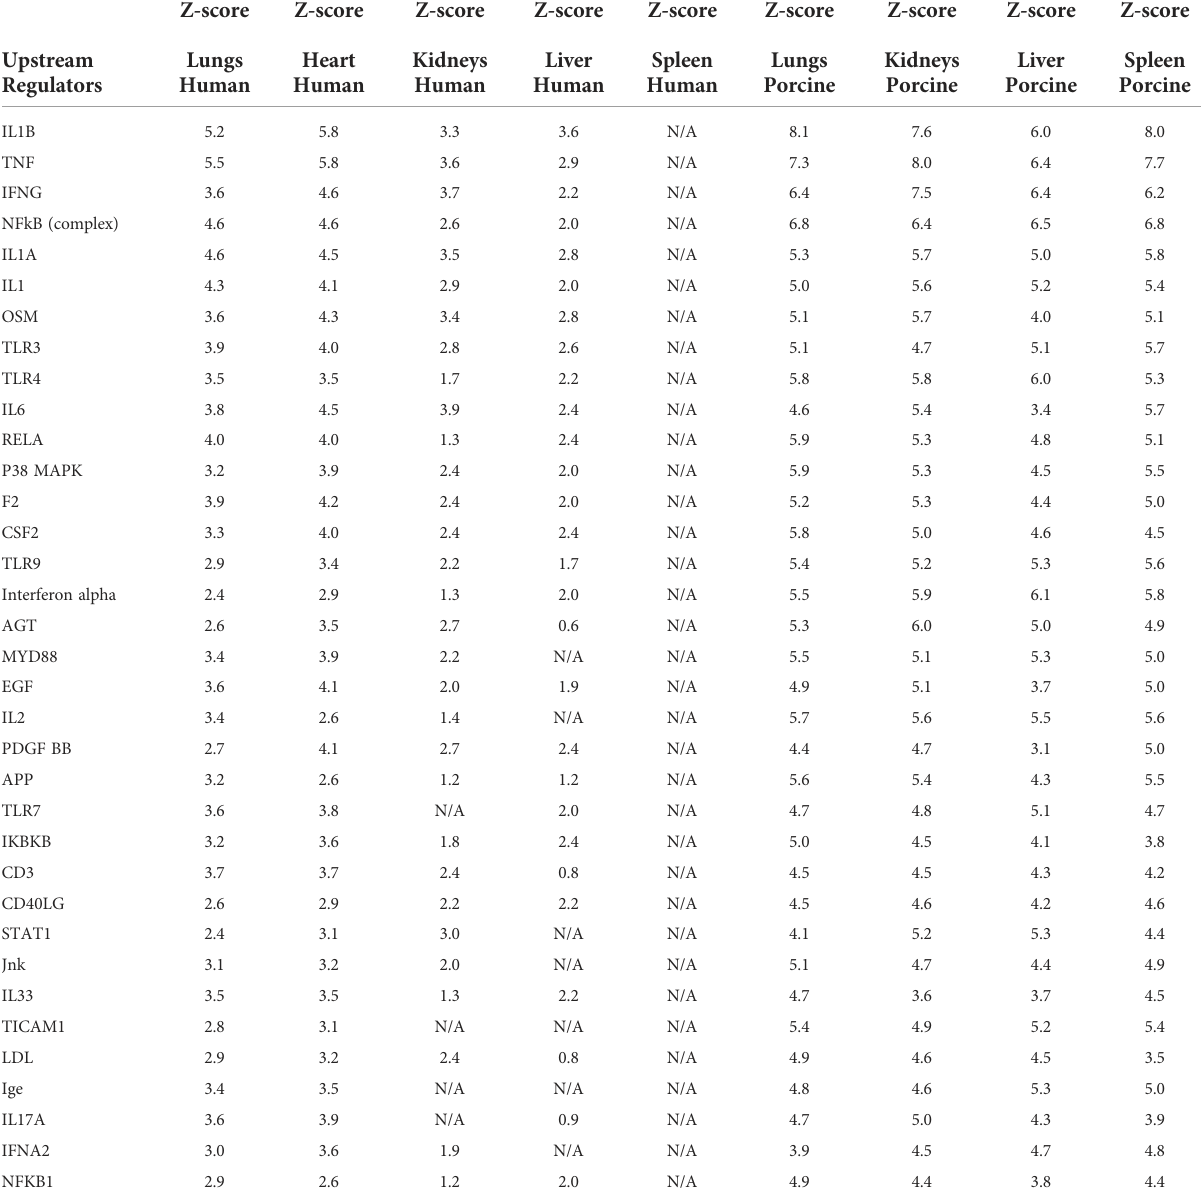
≪ Comparison analysis ≫ of upstream regulators signi fi cantly enriched in FFPE tissue samples from lungs, heart, kidneys, liver, and spleen from meningococcal septic shock patients vs. controlspatients(acutenon-infectiousdeath)andinFFtissuesamplesfromlungs,kidneys,liver,andspleenfromporcinisinfusedwithexponentiallyincreasingnumbersof N.meningitidis (referencestrainH44/76)vs.controlswereperformed.ThetableshowsthetopmostupregulatedupstreamregulatorsrankedaccordingtoexpressionlevelsinFFPEtissuesfromlungs.The Z-score indicates predicted activation state of the upstream regulators. Note that only the top upstream regulators are shown. N/A = not